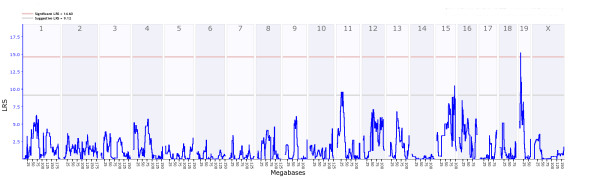
QTL Plot for Residual Noncortal Volume. Here, the effect of the QTL on proximal chromosome 11 is attenuated and no longer significant. There is a suggestive association on the distal portion of chromosome 15 and a significant QTL on chromosome 19. Thus, there is a double dissociation between neocortex and noncortex for significant QTLs on chromosomes 11 and 19.